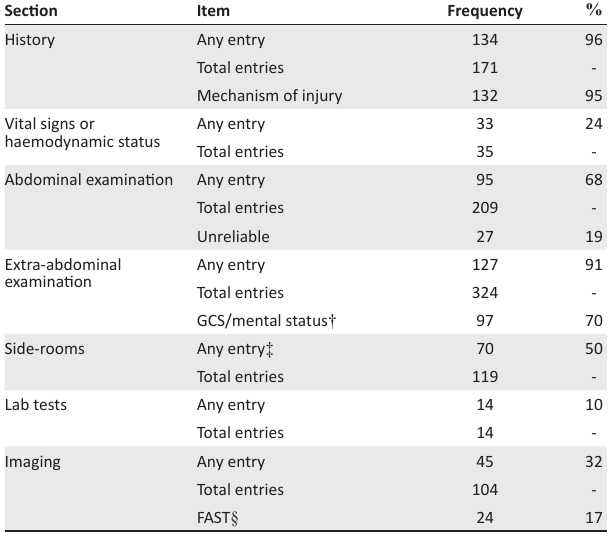
TABLE 2: Frequency of request form detail ( N = 139).